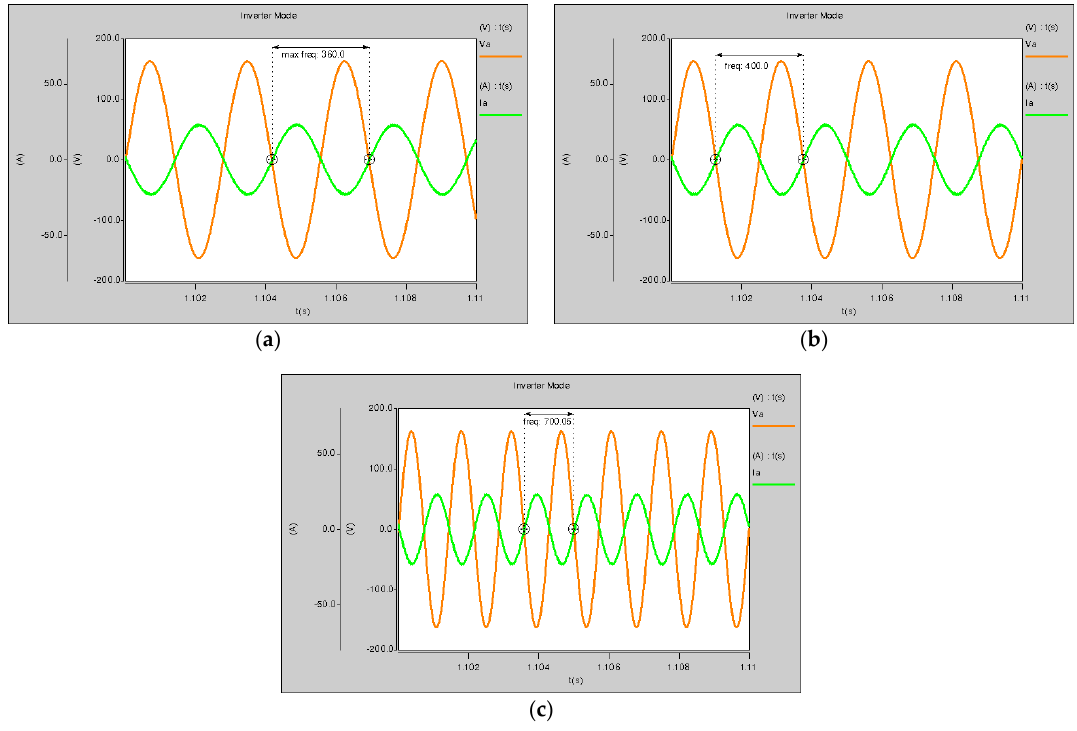
Figure 12. Variable frequncy operation in inverter mode ( a ) 360 Hz; ( b ) 400 Hz; and ( c ) 700 Hz.